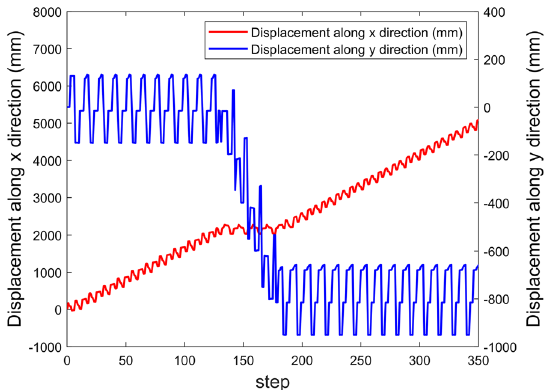
Figure 12 Motion displacement along x and y direction of Octopus robot